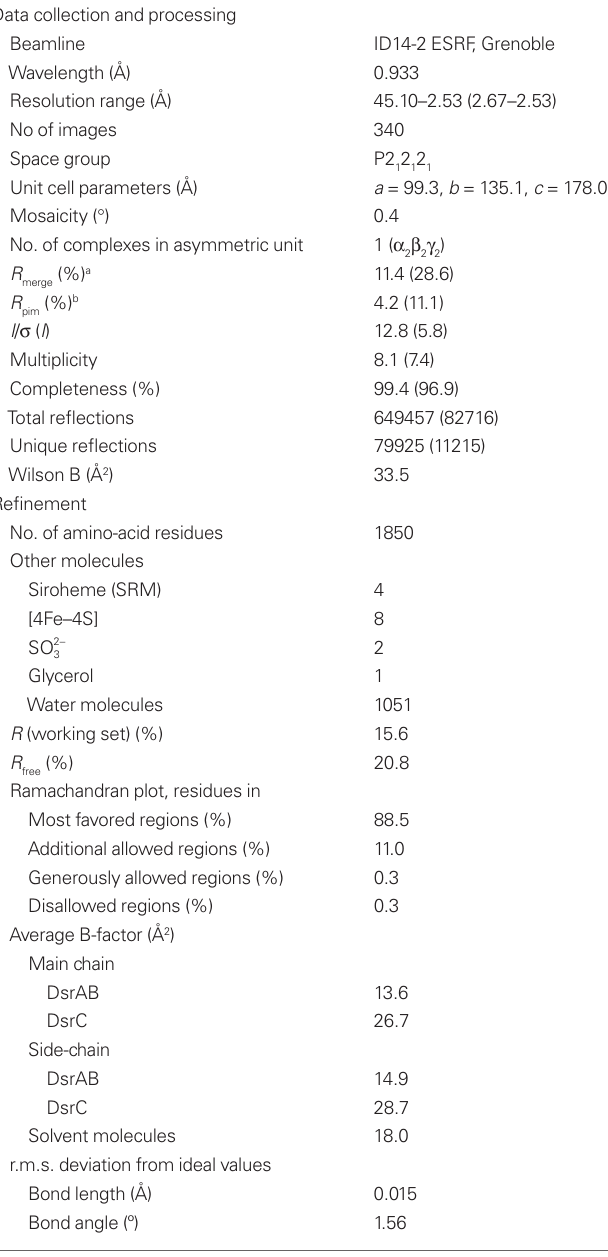
Table 1 | Data collection and refinement